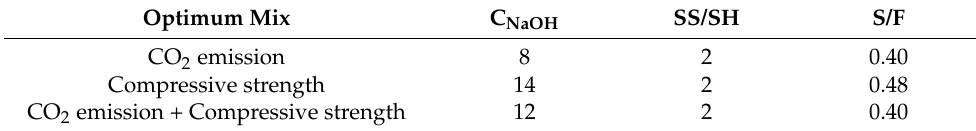
Table 8. Optimum mix based on CO 2 emission and compressive strength.